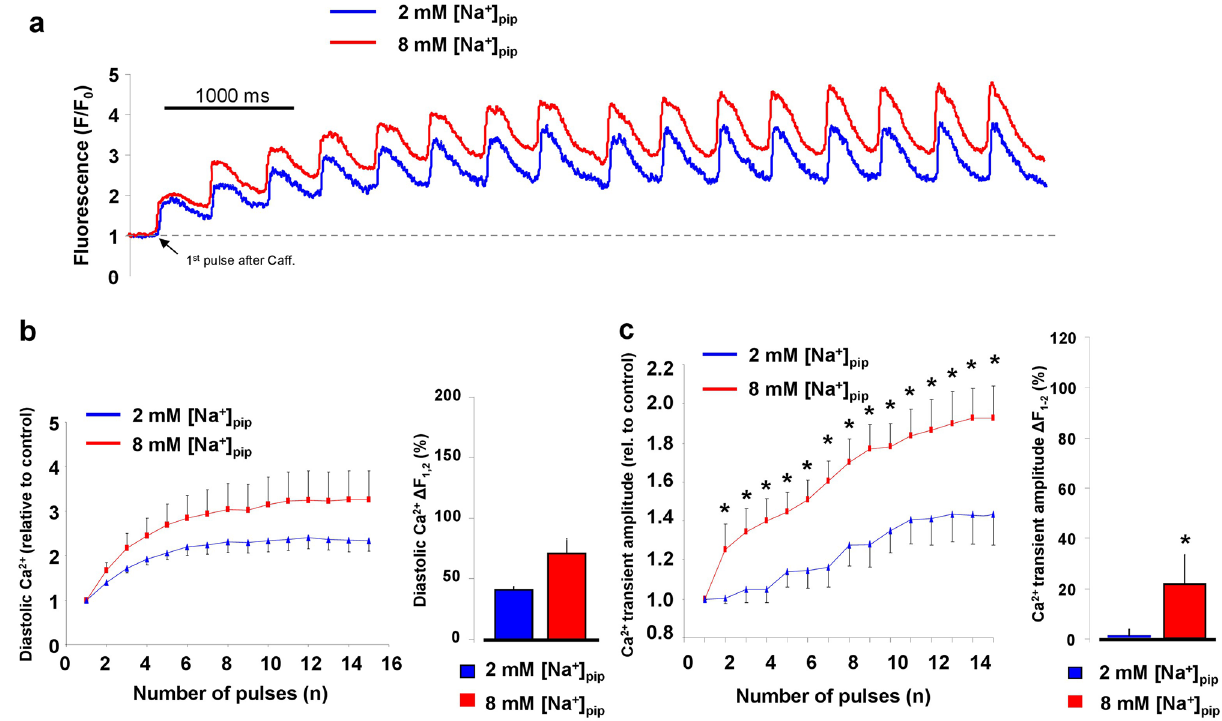
Figure 5. Evaluation of the Ca 2+ -transients after application of 10 mM caffeine. The step-by-step increasing Ca 2+ transients (panel a ) reached their steady-state value after the 10th stimulus where the diastolic Ca 2+ transient (panel b ) was not changed while the transient amplitude (panel c ) was higher in the presence of 8 mM pipette NaCl (red graphs). The bar graph in panel ( c ) indicates faster change of transient amplitude between 1st and 2nd beats when pipette Na + was adjusted to 8 mM while in the case of diastolic Ca 2+ level it was found identical refilling kinetics between 2 (blue column) and 8 (red column) pipette NaCl (bar graph, panel b ). Independent t-test, *means p <